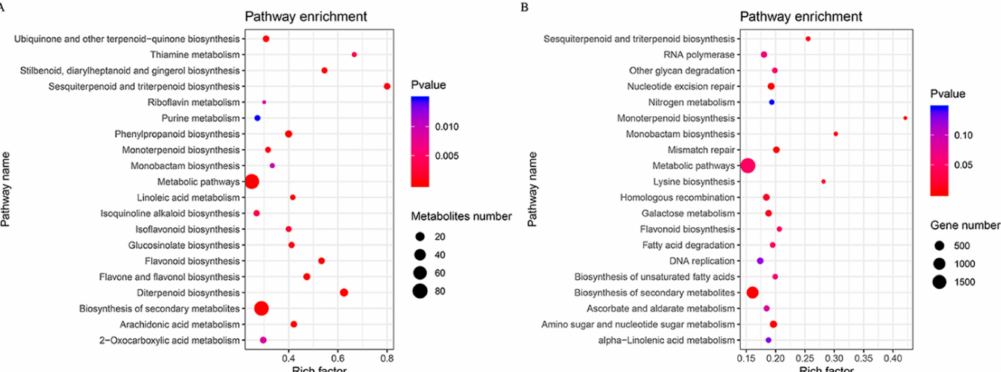
Figure 2. KEGG pathway enrichment analysis. Pathway enrichment of di ff erentially accumulated metabolites ( A ) and di ff erentially expressed genes ( B ). y -Axis indicates the pathway name, x -axis indicates the enriched factor in each of pathways. The bubble size indicates the number of metabolites or genes. The color bar indicates the corrected p-value, the blue represents higher value, the red represents lower